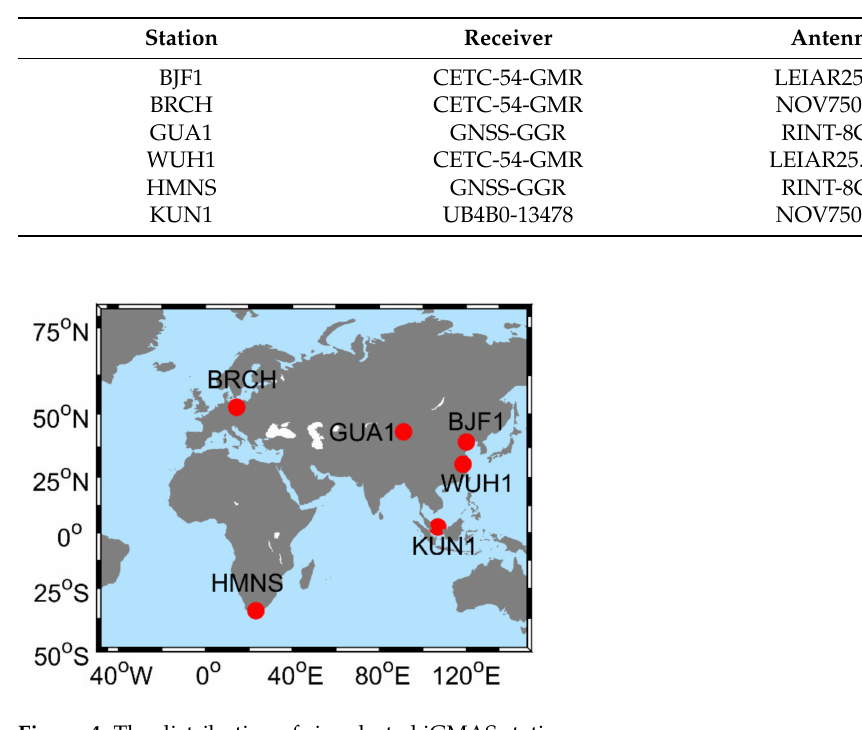
Figure 4. The distribution of six selected iGMAS